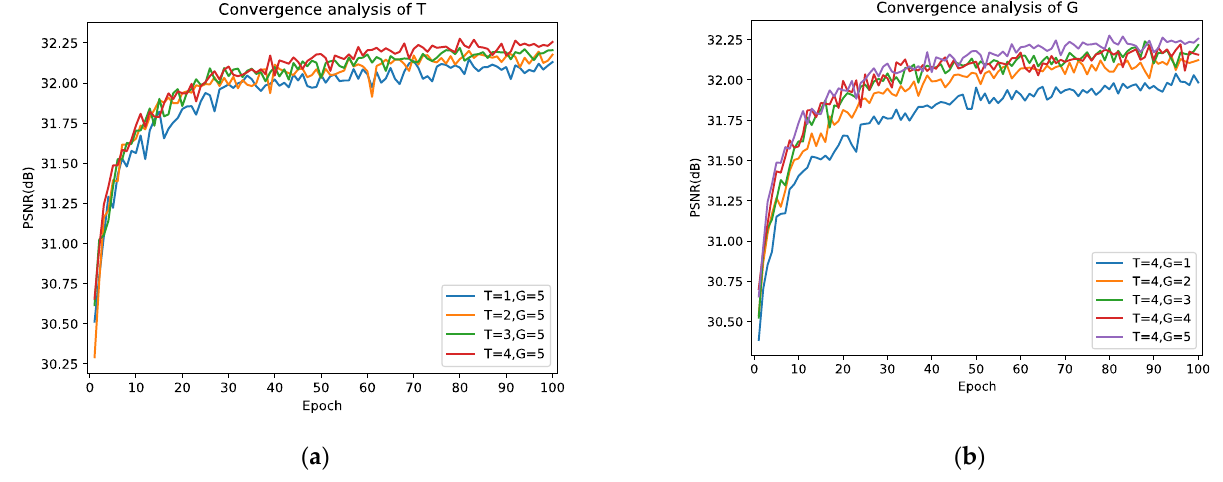
Figure 6. Convergence analysis of T and G on Set5 with BI × 4. (a) is the convergence curve with respect to T, (b) is the convergence curve with respect to G.